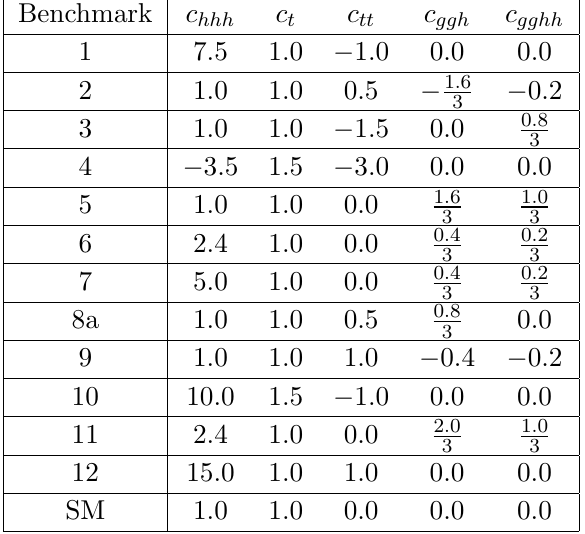
Table 3. Benchmark points used for the distributions shown